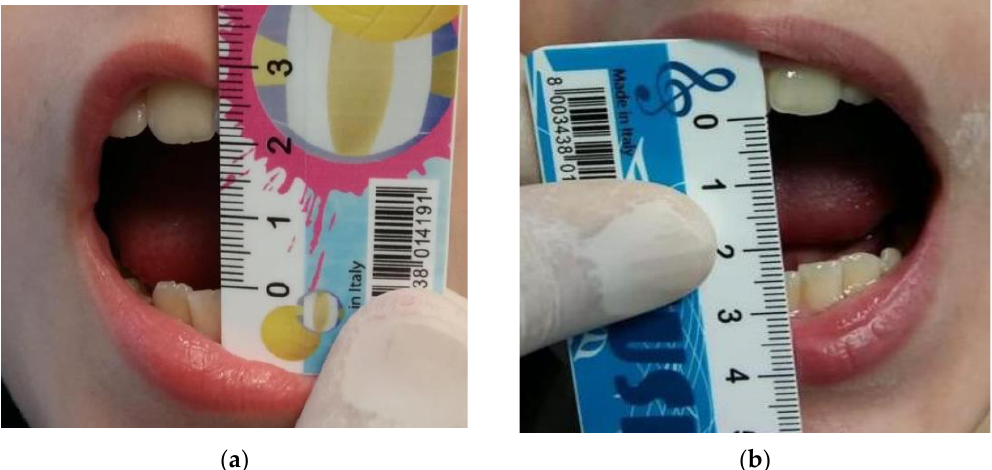
Figure 2. ( a ) Clinical evaluation after the first appointment. ( b ) Clinical evaluation after the second session.